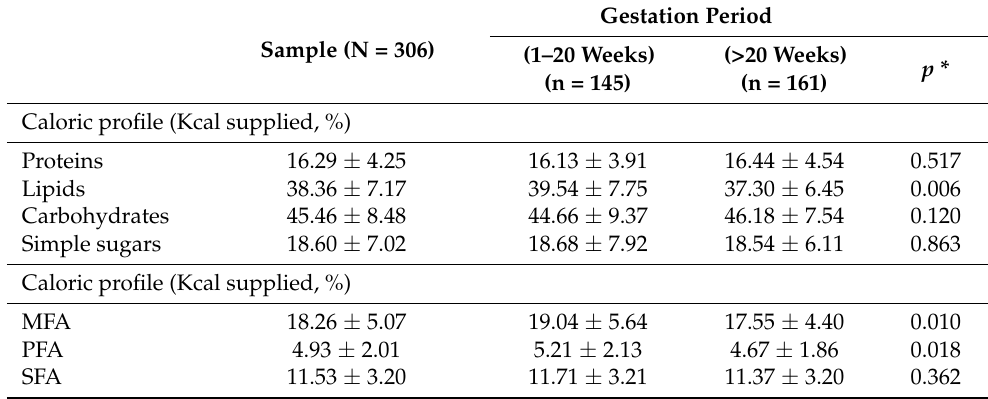
Table 3. Caloric and lipid profiles of the diet according to gestation period. Values in means (SD).